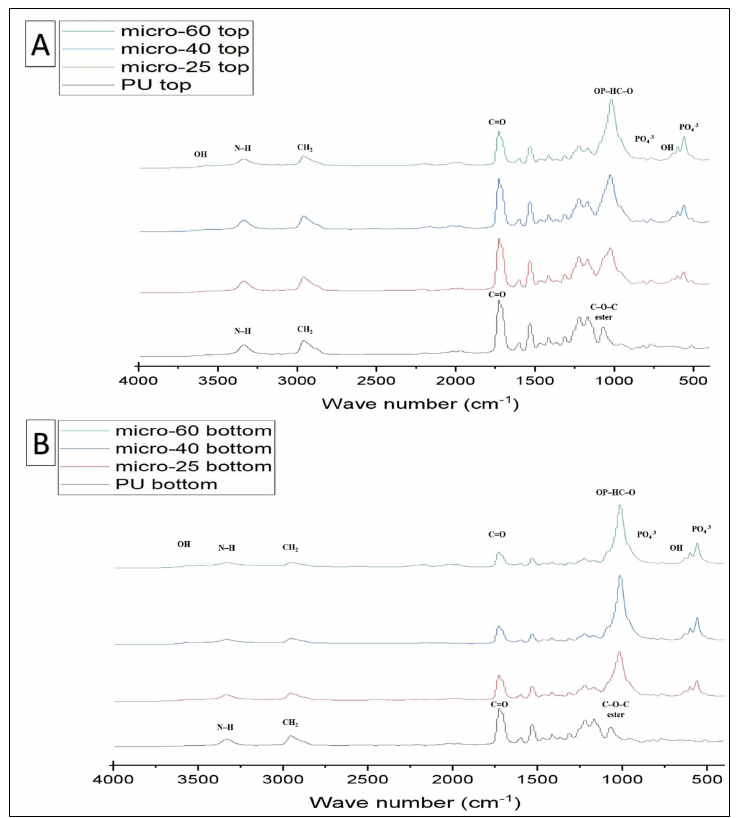
Figure 5. FTIR-ATR Spectra of different groups taking PU as a control ( A ) top surface of PU and PU/HA micro scaffolds ( B ) bottom surface of PU and PU/HA micro scaffolds.